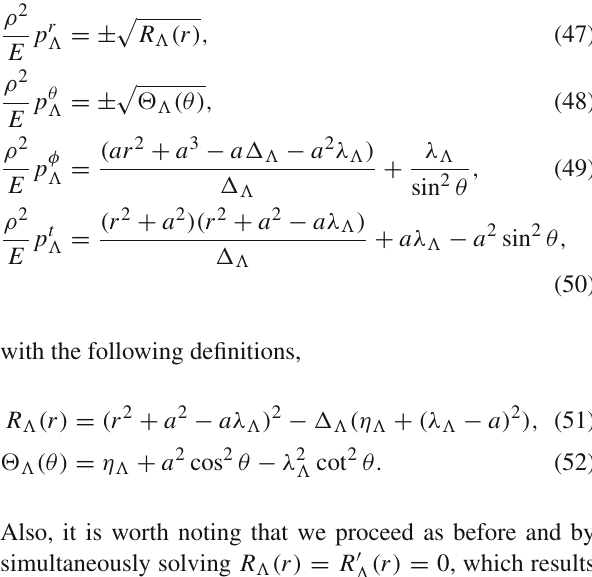
On the other hand, as (cid:2) increases, r ph + , KDS increases while r ph − , KdS decreases. We expect to observe this behaviour on the KdS black hole shadows for varying values of (cid:2) or